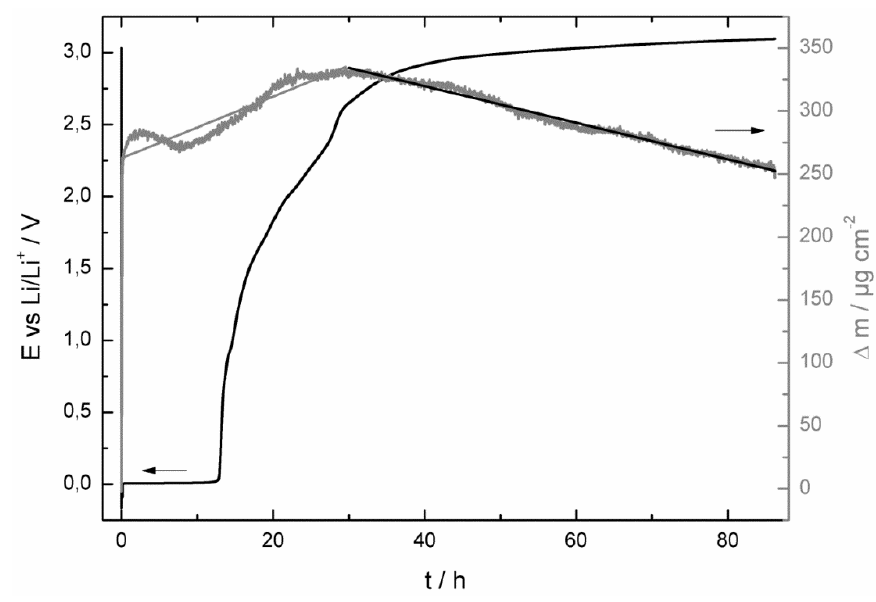
in EC-DEC (3:7, by 6